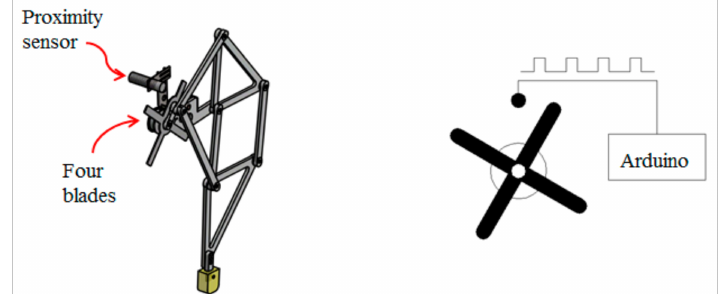
Figure 15. Sensor system to detect the phases of the crank.